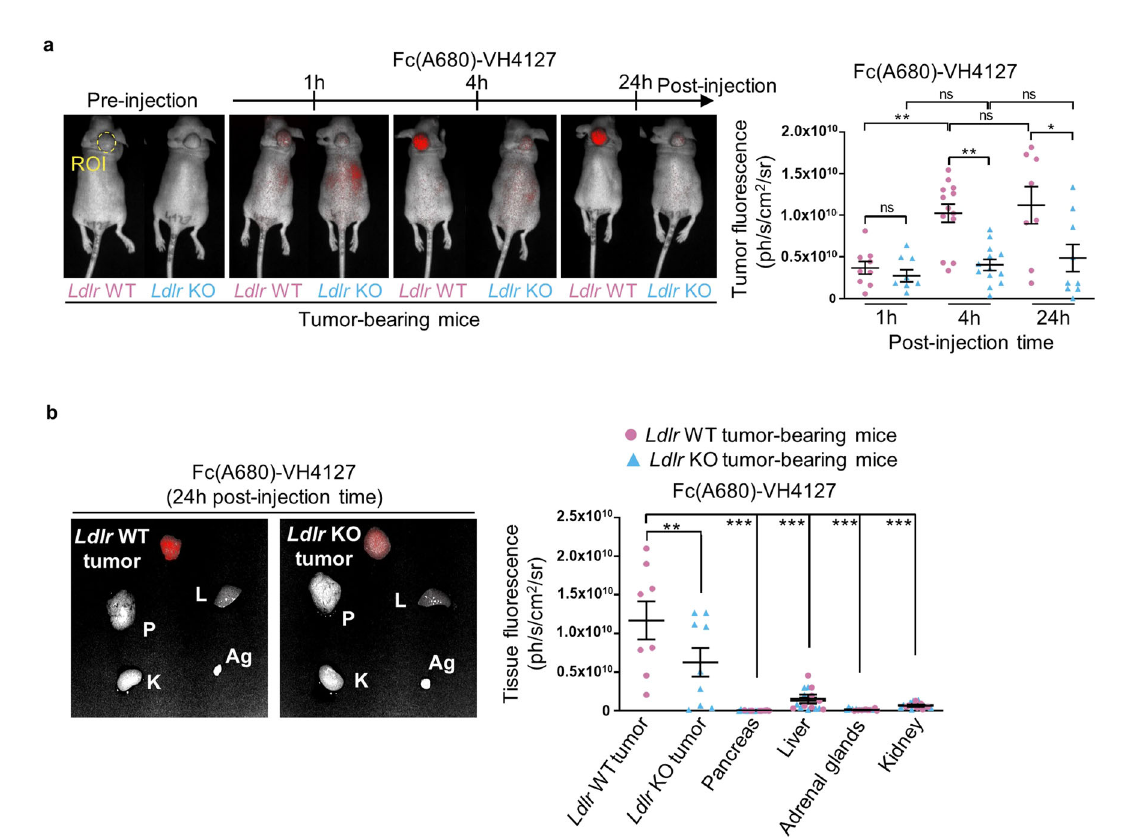
Fig. 4 The Fc(A680)-VH4127 speci fi cally targets subcutaneous pancreatic tumors. a Representative merged fl uorescence and visible light images of Ldlr WT and Ldlr KO pancreatic tumors grown subcutaneously in immunode fi cient mice. Fluorescence acquisitions were performed before intravenous injection (IV) of Fc(A680)-VH4127 conjugate (1 nmole/mouse) and 1, 4, and 24 h after. The kinetic of tumor-speci fi c fl uorescence of Fc(A680)-VH4127 (i.e., region of interest (ROI)) is illustrated and expressed as mean (ph/s/cm 2 /sr) ± s.e.m. b Representative merged fl uorescence and visible light images of the tumors ( Ldlr WT and Ldlr KO), pancreas (P), liver (L), adrenal glands (Ag) and kidney (K) acquired 24 h after administration of Fc(A680)-VH4127 conjugate. The tissue-speci fi c fl uorescence of Fc(A680)-VH4127 was illustrated and expressed as mean (ph/s/cm 2 /sr) ± s.e.m. a , b One-way ANOVA with post-hoc Tukey HSD test, ns: no signi fi cant difference, * p < 0.05, ** p < 0.01, *** p < 0.001. n = 8 – 13 mice at each